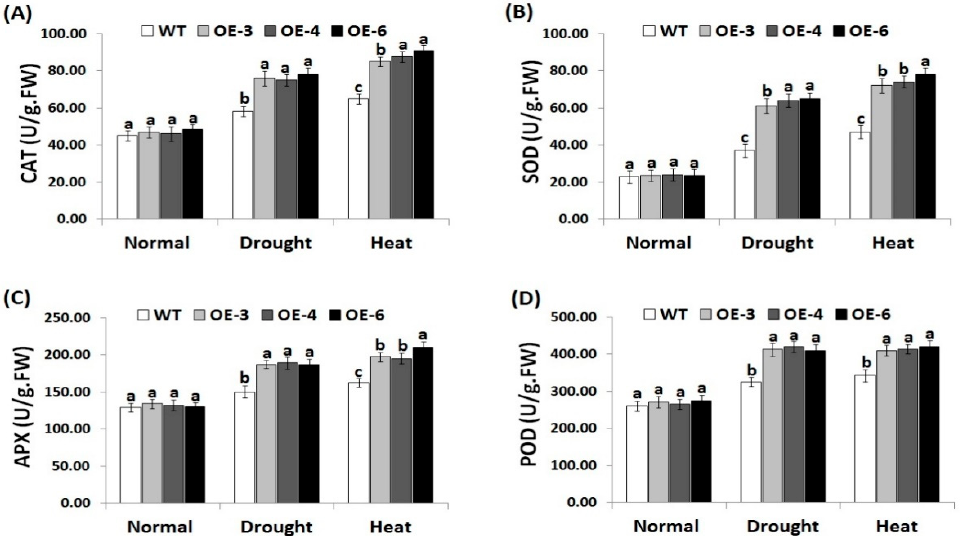
Figure 5. Activities of catalase (CAT) ( A ), superoxide dismutase (SOD) ( B ), ascorbate peroxidase (APX) ( C ), and peroxidase (POD) ( D ) in the wild ‐ type and transgenic rice plants overexpressing OsRab7 subjected to normal, drought, and heat stress conditions. Data are means ± SE (n = 3). Different letters above the columns indicate significant differences between rice lines ( p ≤ 0.05).